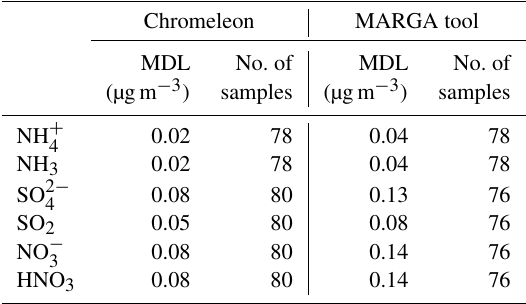
Table 1. Method detection limits (MDL) for chromatograms pro- cessed by MARGA tool and reintegrated by